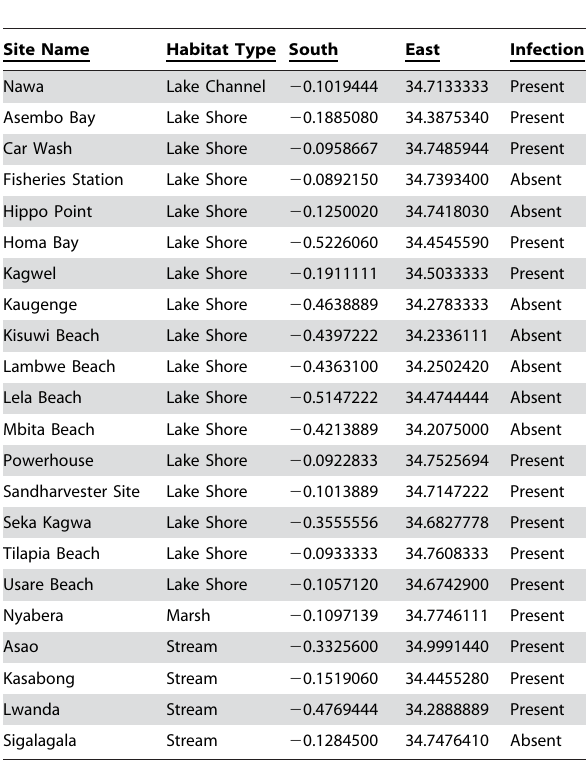
Table 1. Collection sites for snails of the genus Biomphalaria and their schistosome parasites in Western